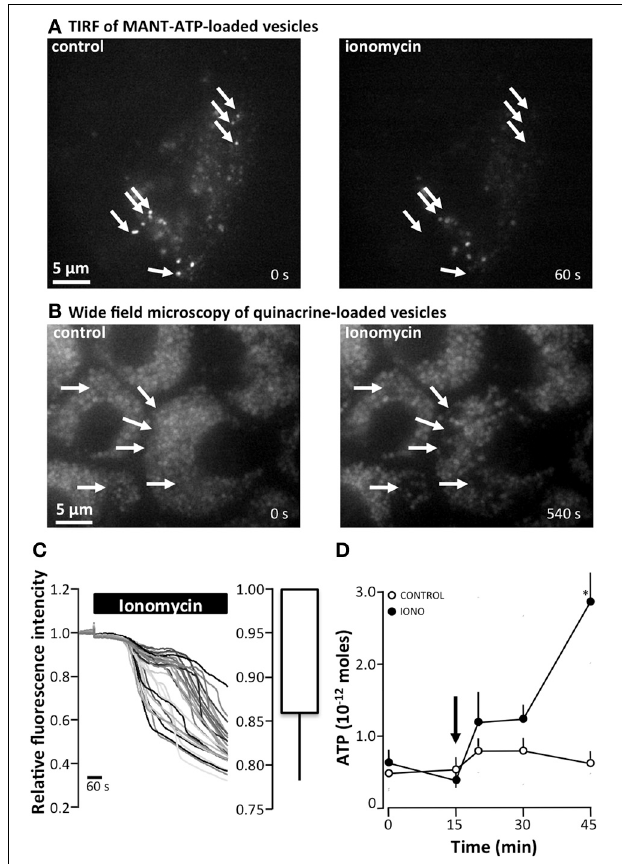
FIGURE 7 | The effect of ionomycin on ATP release and vesicular fusion in MDCK cells (A) total internal reflection fluorescence (TIRF) microscopy of MDCK cells loaded with MANT-ATP (25 µ M, 5h, 37 ◦ C) showing vesicular fusion after the addition of ionomycin (1 µ M). Arrows indicate vesicles that abruptly disappeared from the evanescence field. (B) Ionomycin (1 μ M)-induced vesicular fusion as indicated by wide-field fluorescence microscopy of MDCK cells loaded with quinacrine (5 μ M, 30min, 37 ◦ C). Arrows indicate vesicles that display an abruptly drop in fluorescence. (C) Right: Original trace of the effect of ionomycin (1 μ M, 37 ◦ C) on the relative fluorescence intensity of quinacrine-loaded MDCK cells. The left panel present the mean ± s.e.m. from 6 experiments. (D) ATP release from MDCK cells induced by apical application of ionomycin (IONO, 1 μ M). The arrow indicates the addition of ionomycin or the control solution; the mean ± s.e.m. values are presented ( n = 10). The asterisk indicates statistical significance.